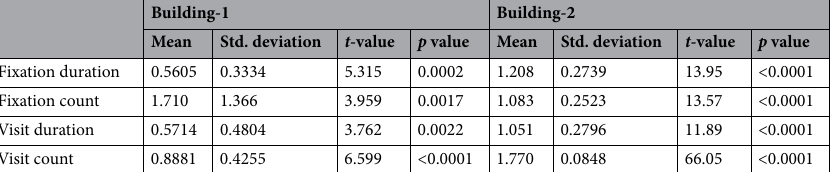
Table 1. Descriptive statistics of eye tracking metrics for spatial distribution of surrounding vs. damage regions where p < 0.05